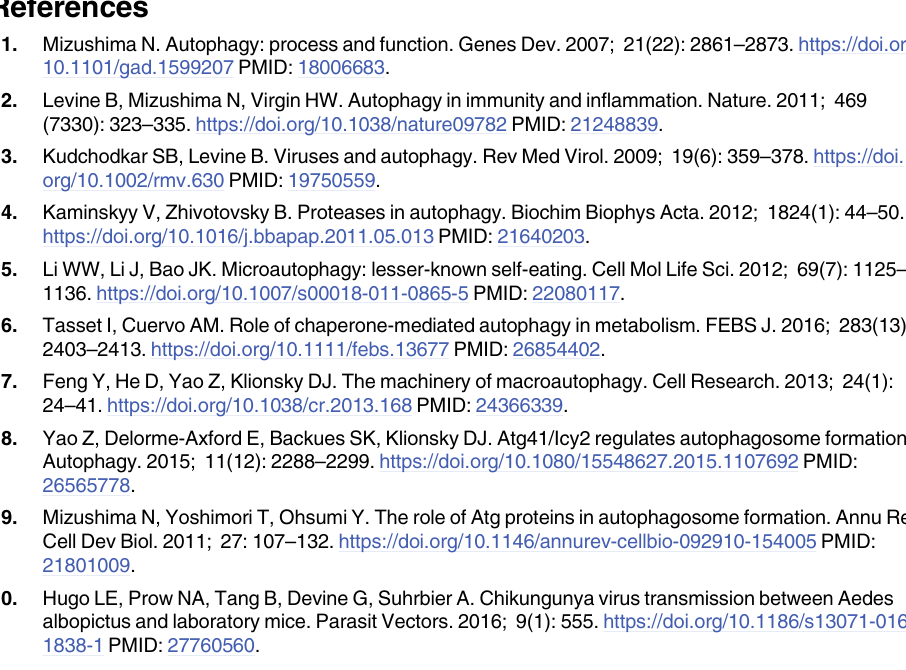
S1 Table. Primers used in this study. S2 Table. The information of siRNA used in this